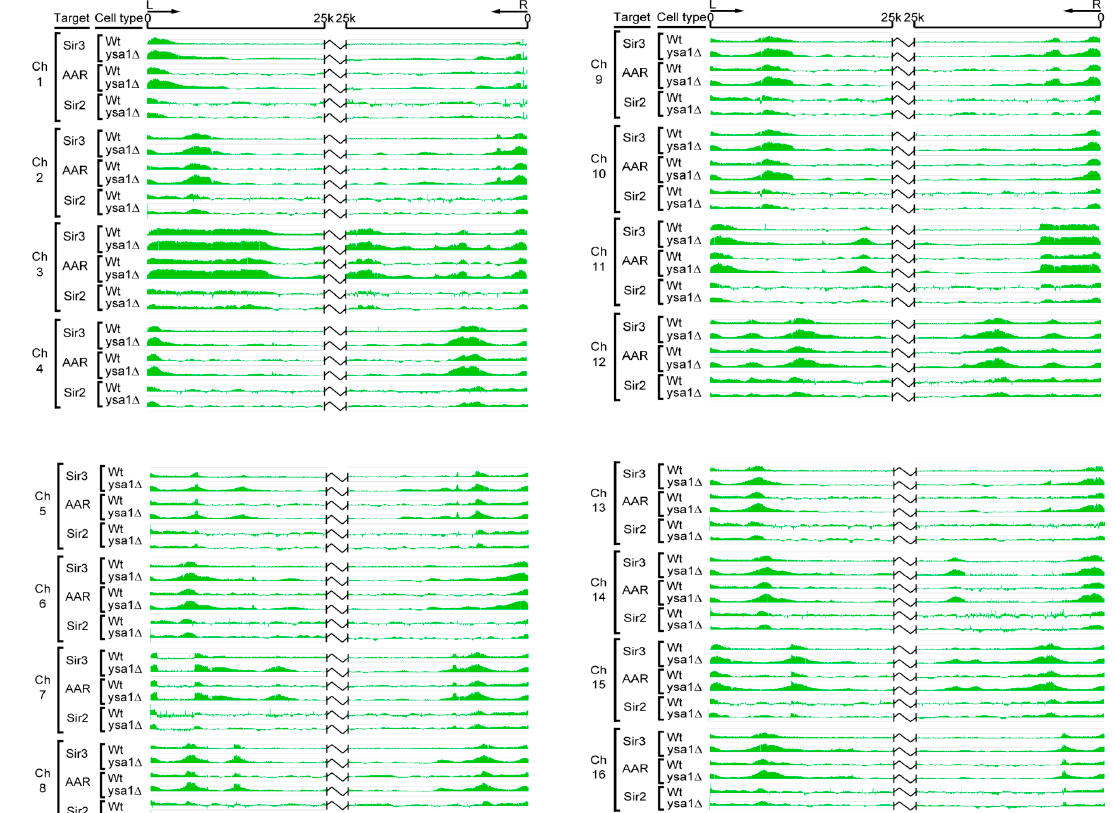
Figure 2. Chromosomal distribution of Sir2, Sir3, and AAR over telomeric regions. The chromosomal distributions of Sir3, Sir2, and AAR were determined through chromatin immunoprecipitation (ChIP)-on-chip and chromatin a ffi nity purification (ChAP)-on-chip assays. For each chromosome, data are presented for a 25 kb region from the left (L) and right (R) of the chromosome ends for Sir3 in wild-type cells, Sir3 in ysa1 -deletion cells, AAR in wild-type cells, AAR in ysa1 -deletion cells, Sir2 in wild-type cells, and Sir2 in ysa1 -deletion cells, as